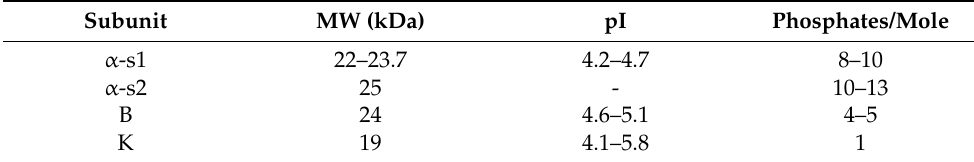
Table 2. Casein subunits